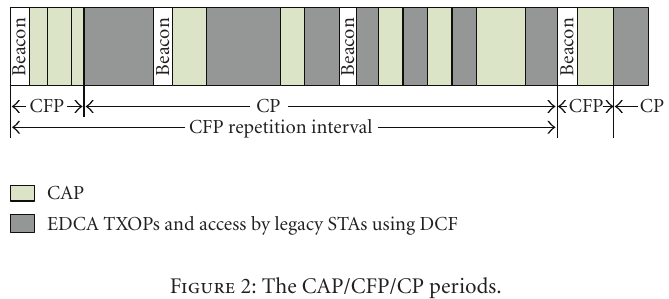
Figure 2: The CAP/CFP/CP